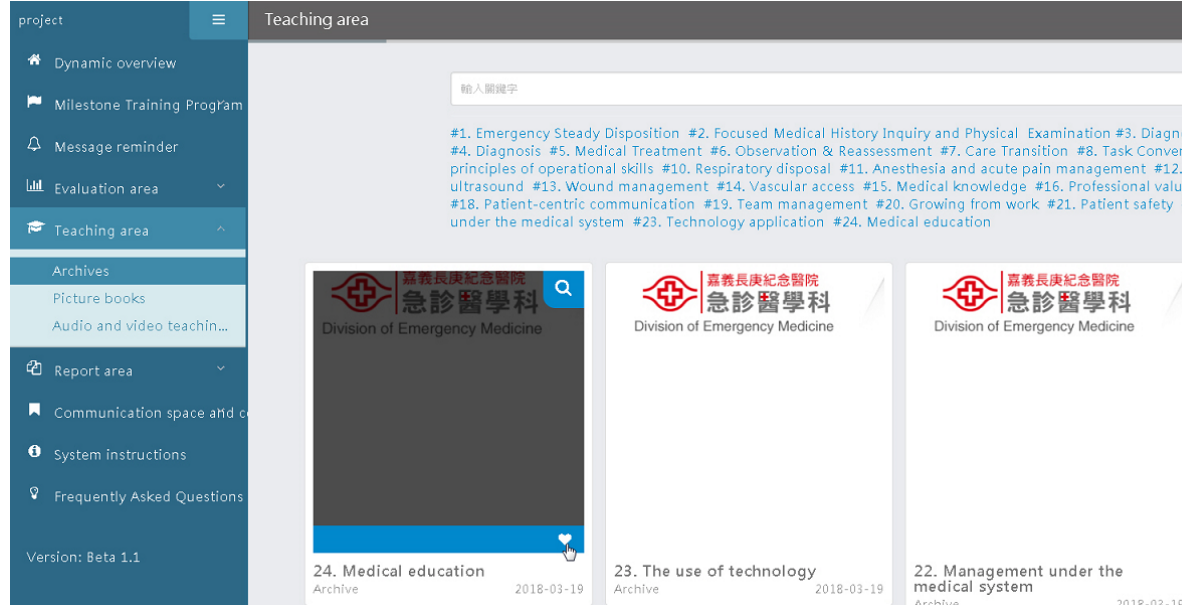
Figure 7. E-learning platform interface.